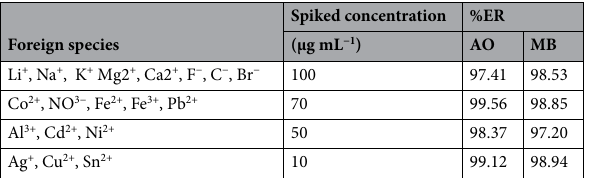
Table 5. Effects of influence substances on the determination of AO and MB.